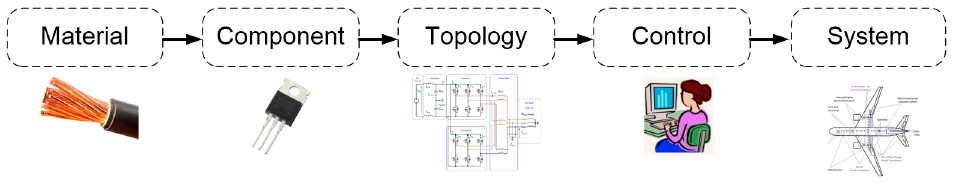
Figure 1. From the material to the system: different levels of choice to make.